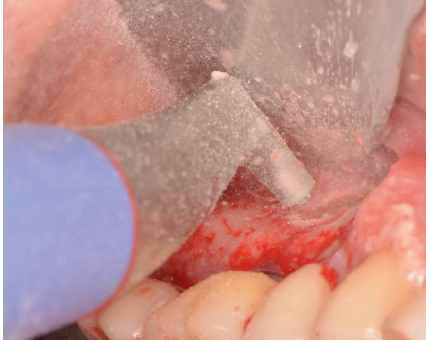
Figure 15: The air powder flow was used to decontaminate the implant surface.